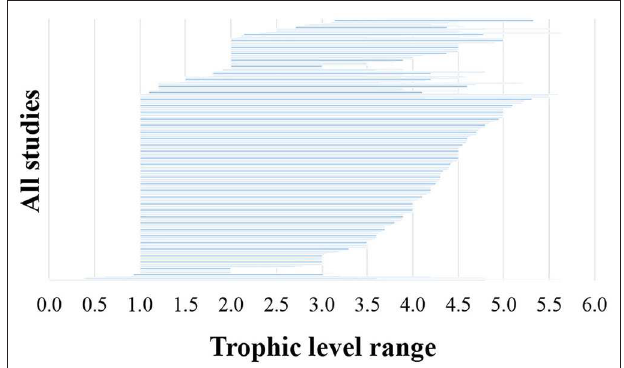
FIGURE 5 | Range of the trophic levels considered ( N =